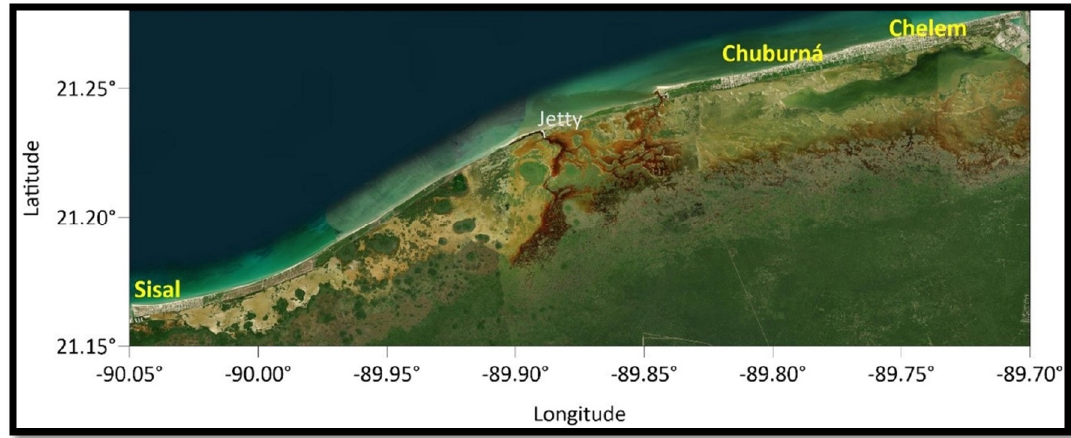
Figure 6. Aerial view of the villages around La Carbonera lagoon (the jetty is shown as a